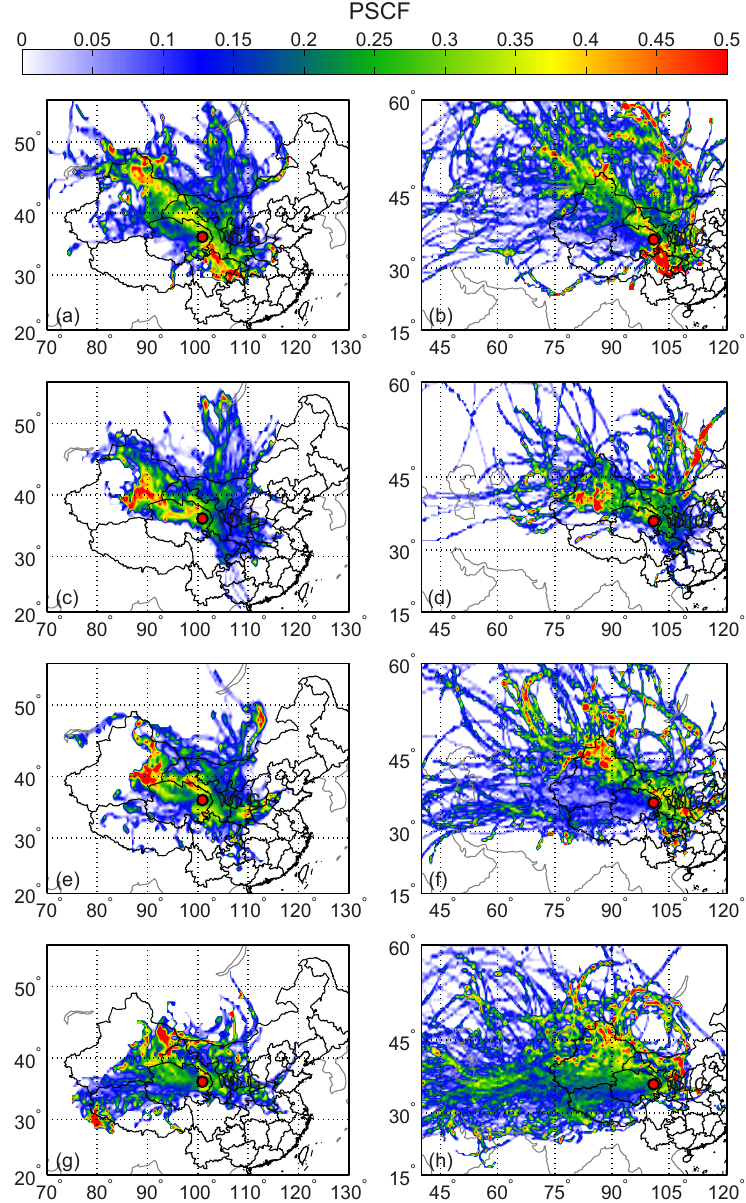
Figure 1. The 1994–2013 climatology of air-mass origins at WLG in the PBL (a, c, e, g) and FT (b, d, f, h) for spring (a, b) , summer (c, d) , autumn (e, f) , and winter (g, h) based on the PSCF analysis of ozone concentrations higher than the 75th percentile value (Sect.